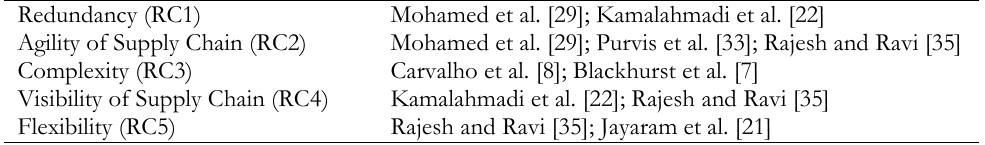
Table 2. The resilience criteria in evaluating the performance of